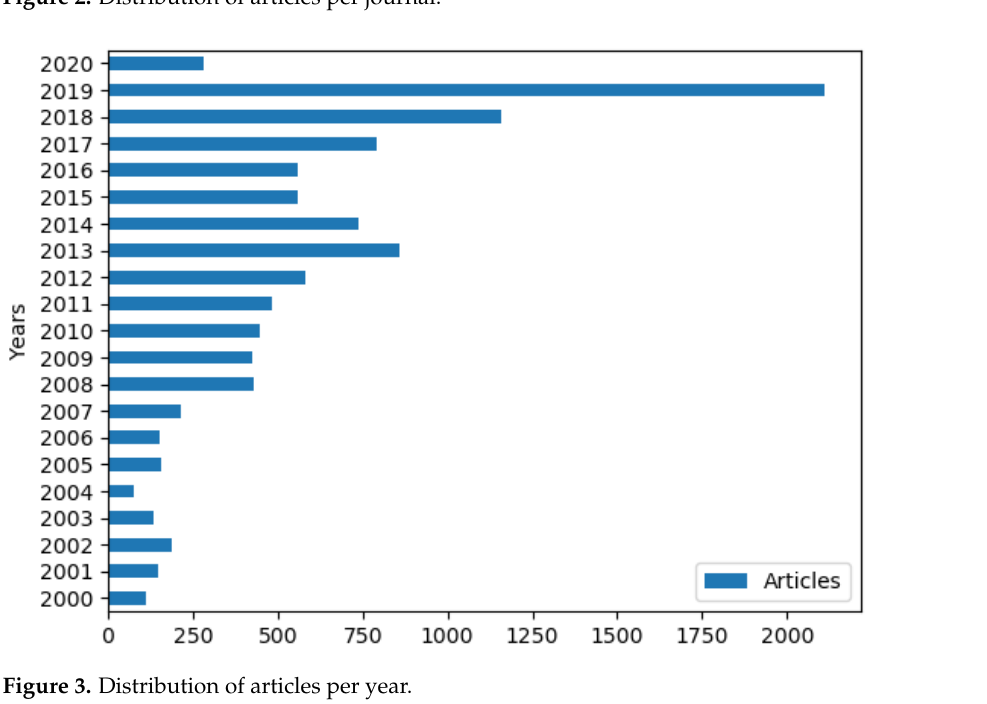
Figure 2. Distribution of articles per journal.